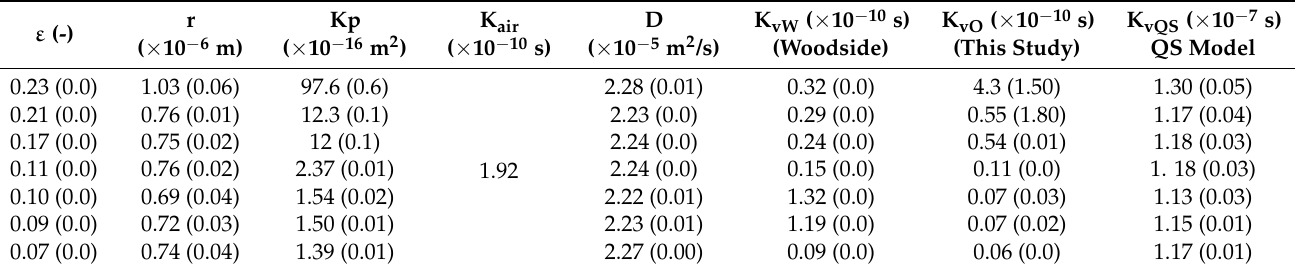
Table 7. Values of the water vapor permeability.